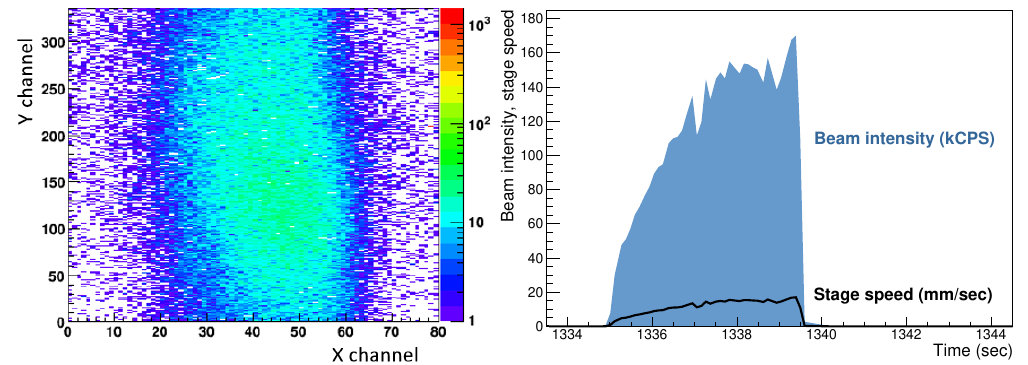
Figure 11 . Left: a beam pro(cid:12)le measured by the silicon pixel detector in 2016 beam test. The sensor area correspond to 2.0 cm (cid:2) 1.9 cm. Right: the time structure of the proton beam measured by the scintillation counter, and the speed of target